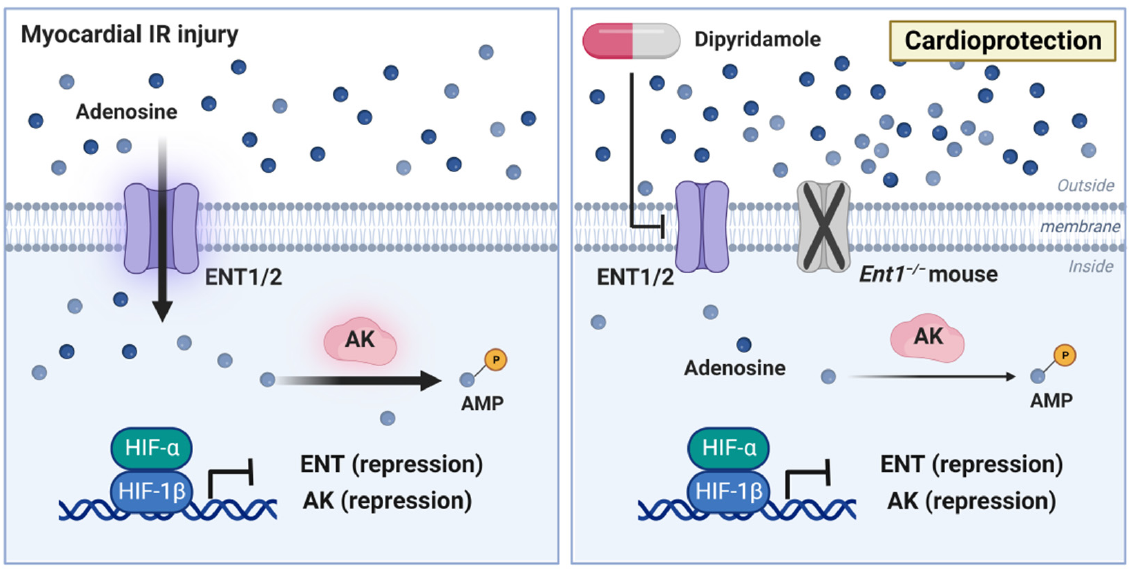
Figure 4. HIF contributes to attenuated adenosine uptake, reduced adenosine metabolism and con- comitant cardioprotection during myocardial ischemia-reperfusion injury. Equilibrative nucleoside transporters (ENTs) regulate the uptake of adenosine from the extracellular towards the intracellular compartment where the major routes of adenosine removal is based on phosphorylation to AMP via adenosine kinase, thereby modulating adenosine levels. During myocardial ischemia-reperfusion injury, HIF transcriptionally represses ENT1, ENT2 and adenosine kinase, leading to elevated extracellular adenosine levels. The inhibition of ENTs in mice with dipyridamole or global deletion of Ent1 showed decreased intracellular adenosine uptake and increased extracellular adenosine levels, ultimately exerting cardioprotective effects. These indicate the contribution of HIF-dependent